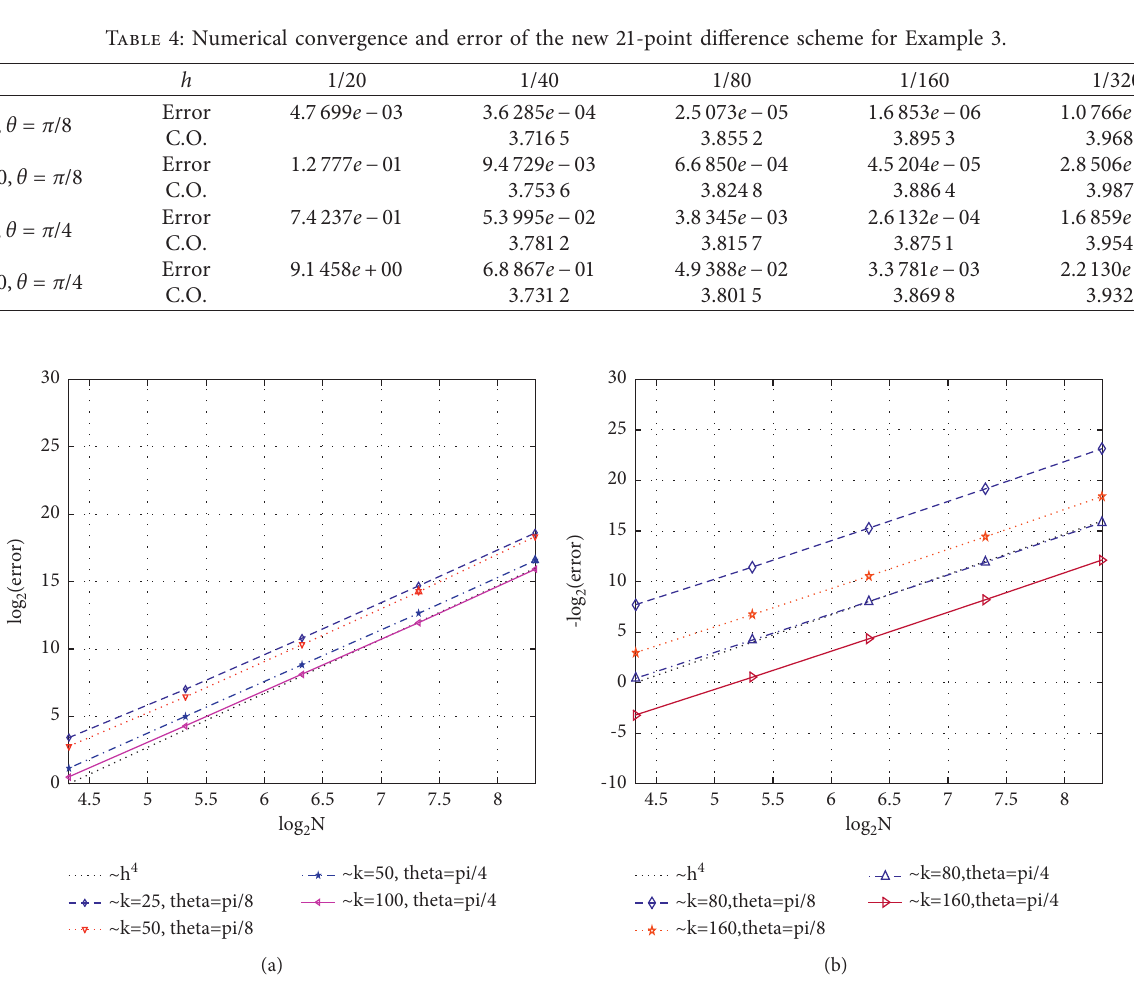
Figure 8: (a) Error in the C-norm for Example 2. (b) Error in the C-norm for Example